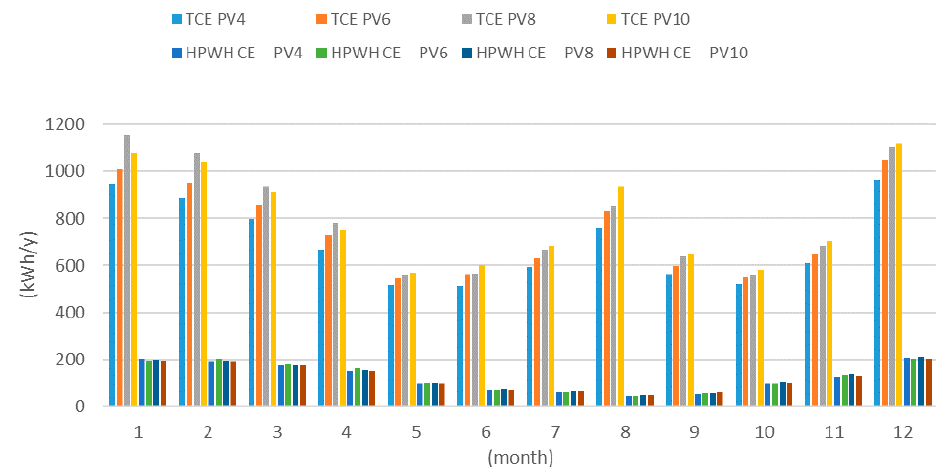
Figure 17. Monthly total consumption and HPWH consumption of PV.